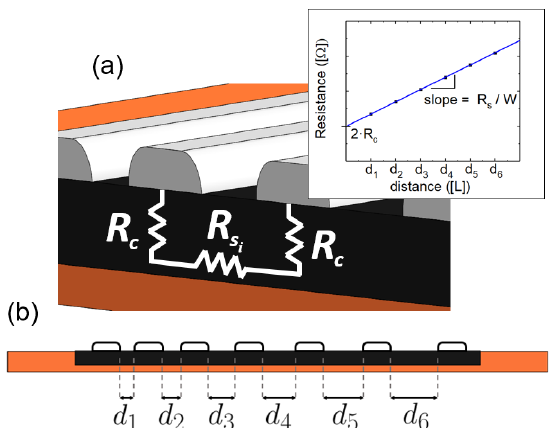
Figure 2. ( a ) equivalent Transmission Line Method (TLM) electrical circuit under two consecutive printed electrodes ( R c : contact resistance, R si : total resistance between contacts i and i + 1). The inset shows a model of the total resistance ( R T ) as a function of the distance between consecutive lines and its relation with the ablated Kapton R (cid:13) sheet resistance ( R S ) and contact resistance ( R c ); ( b ) printed contacts are positioned over the modified Kapton R (cid:13) surface at a distance d i from each other, where d i ranges from d 1 = 1 mm to d 6 = 3.5 mm in 0.5 mm